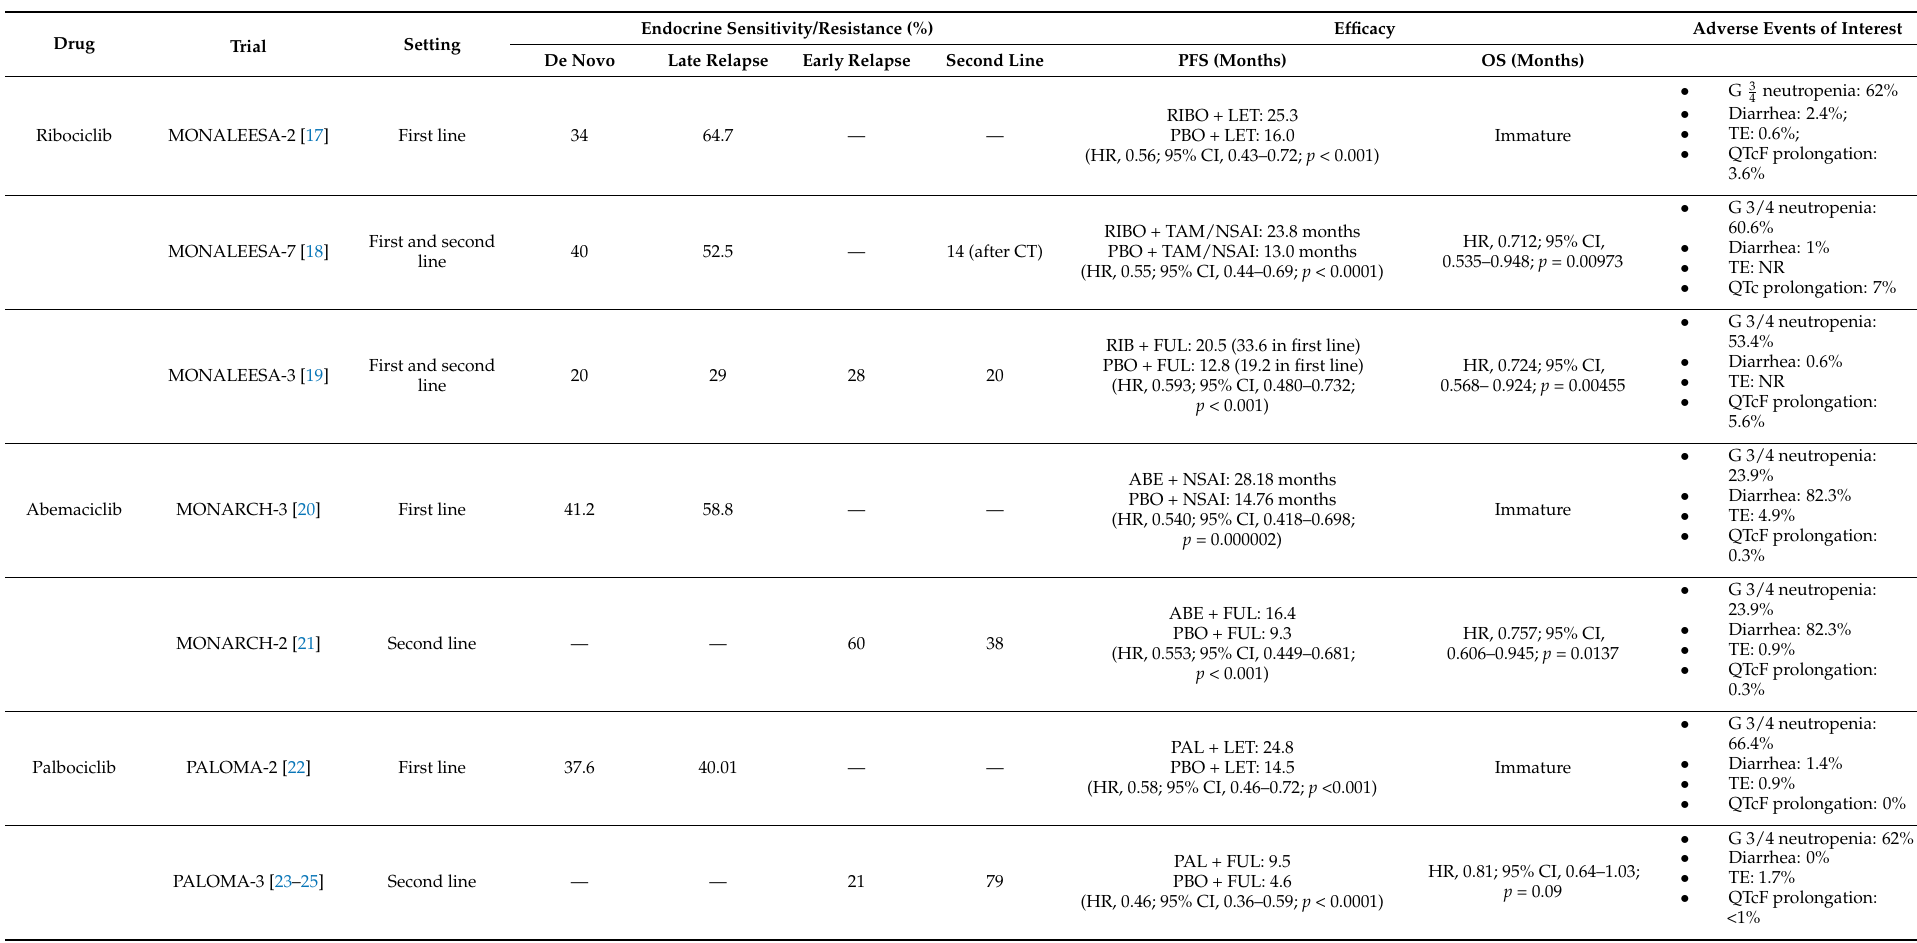
Table 1. CDK4/6 inhibitors phase 3 trials according to endocrine sensitivity/resistance patients representation and outcome